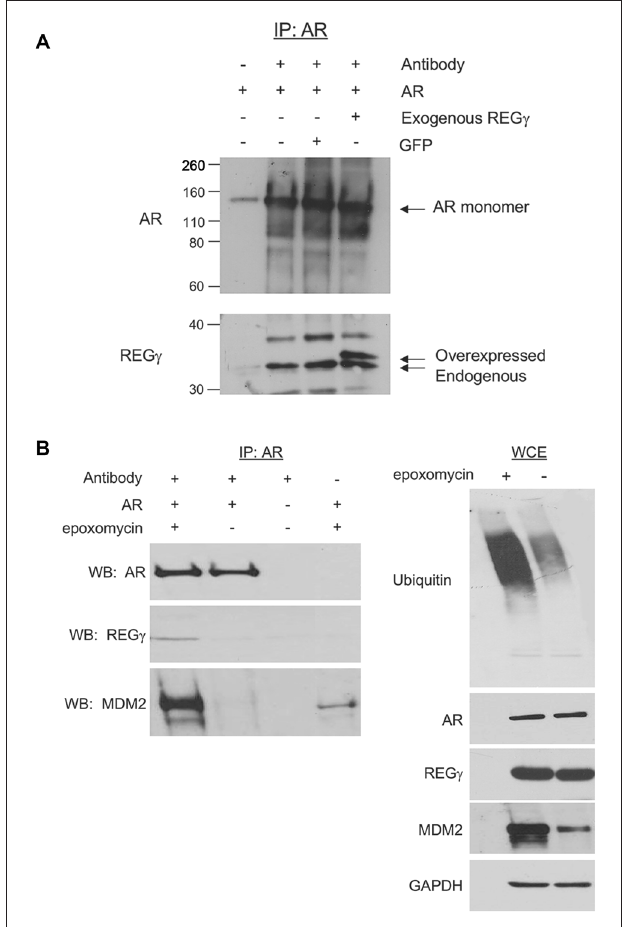
FIGURE 4 | AR interacts with REG γ . (A) PC12 ARQ112 cells were transiently transfected with FLAG-REG γ or GFP and then induced with Dox and treated with DHT for 72 h. Lysates were immunoprecipitated with AR(H280) antibody, separated by SDS-PAGE and protein complexes detected by Western analysis using AR(318) and REG γ antibodies. Included controls are no antibody and no transfection. (B) PC12 ARQ112 cells were induced with Dox and treated with DHT for 48 h and then treated with or without epoxomycin for an additional 12 h. (Left) AR was immunoprecipitated with AR(H280) antibody. Included controls have no AR expression or no antibody in the IP. Western blot analysis was carried out with AR(318), REG γ and MDM2 antibodies to evaluate protein complexes. (Right) Whole cell extracts (WCE) used for IP were evaluated for respective protein levels by Western blot analysis. GAPDH was employed as a loading